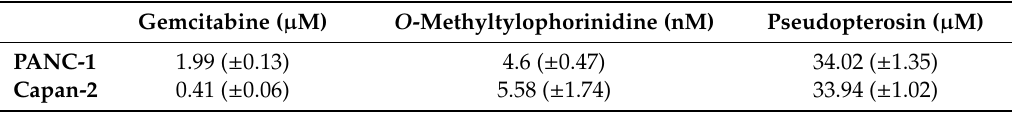
Table 2. IC 50 values of cell death induced by O -methyltylophorinidine, pseudopterosin A-D,